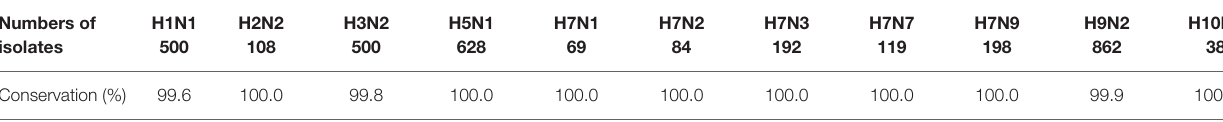
TABLE 1 | Conservation of Y78 among NPs of different subtypes of influenza A